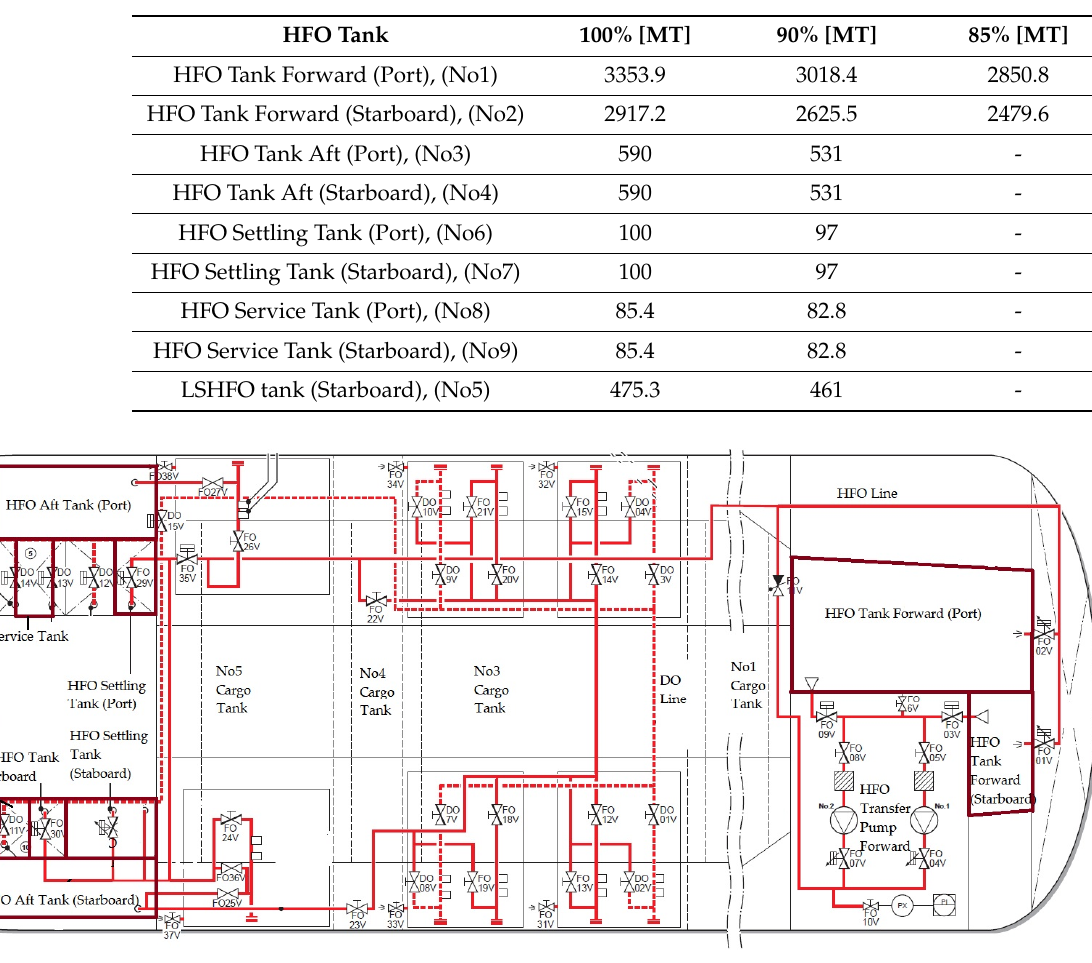
Figure 1. HFO bunker distribution on the LNG carrier.